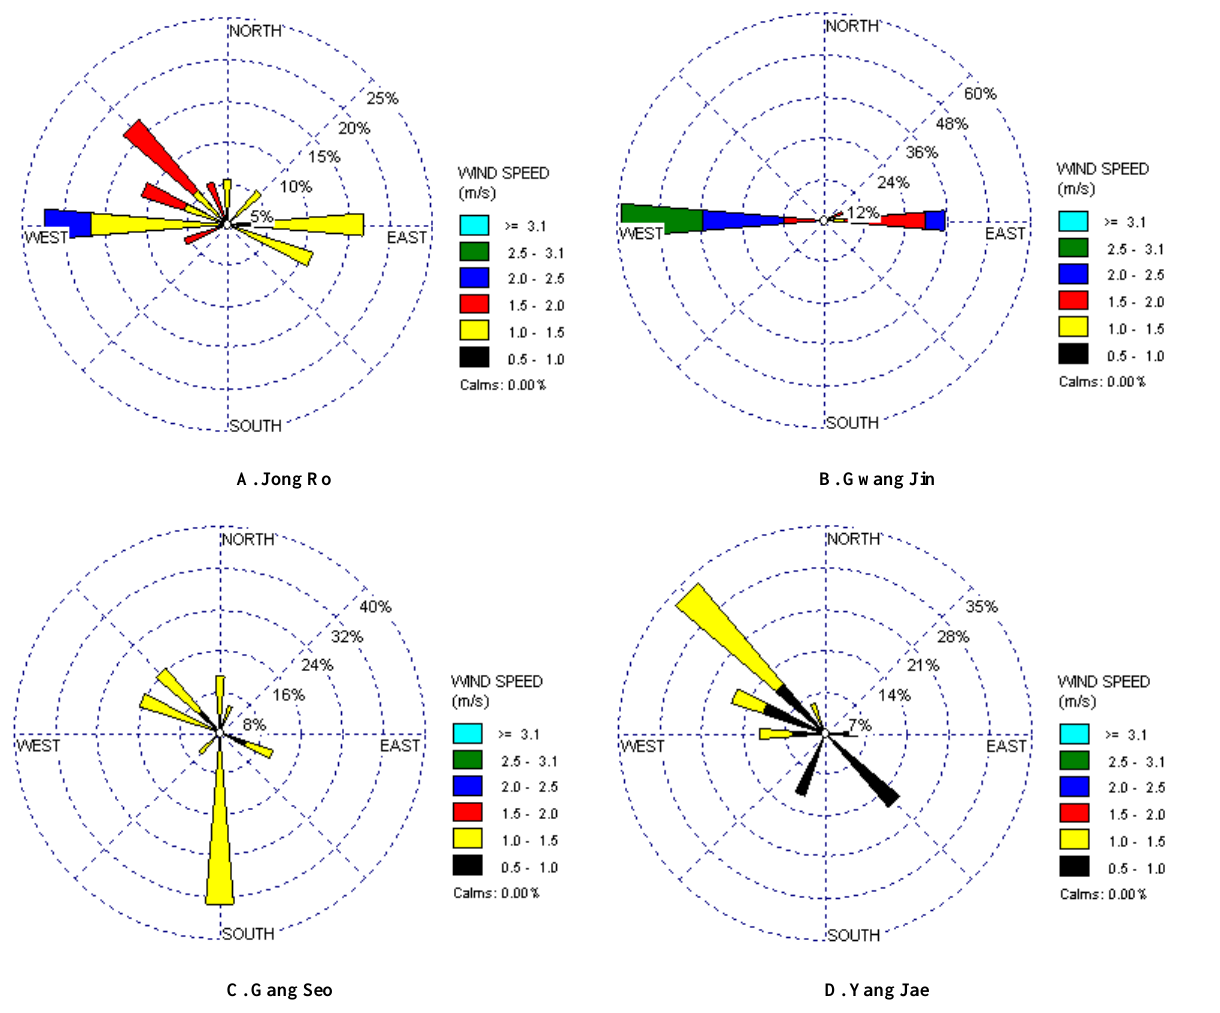
FIGURE 2. Frequency distribution of wind rose patterns at the four study sites during the study period (February to July 2009).